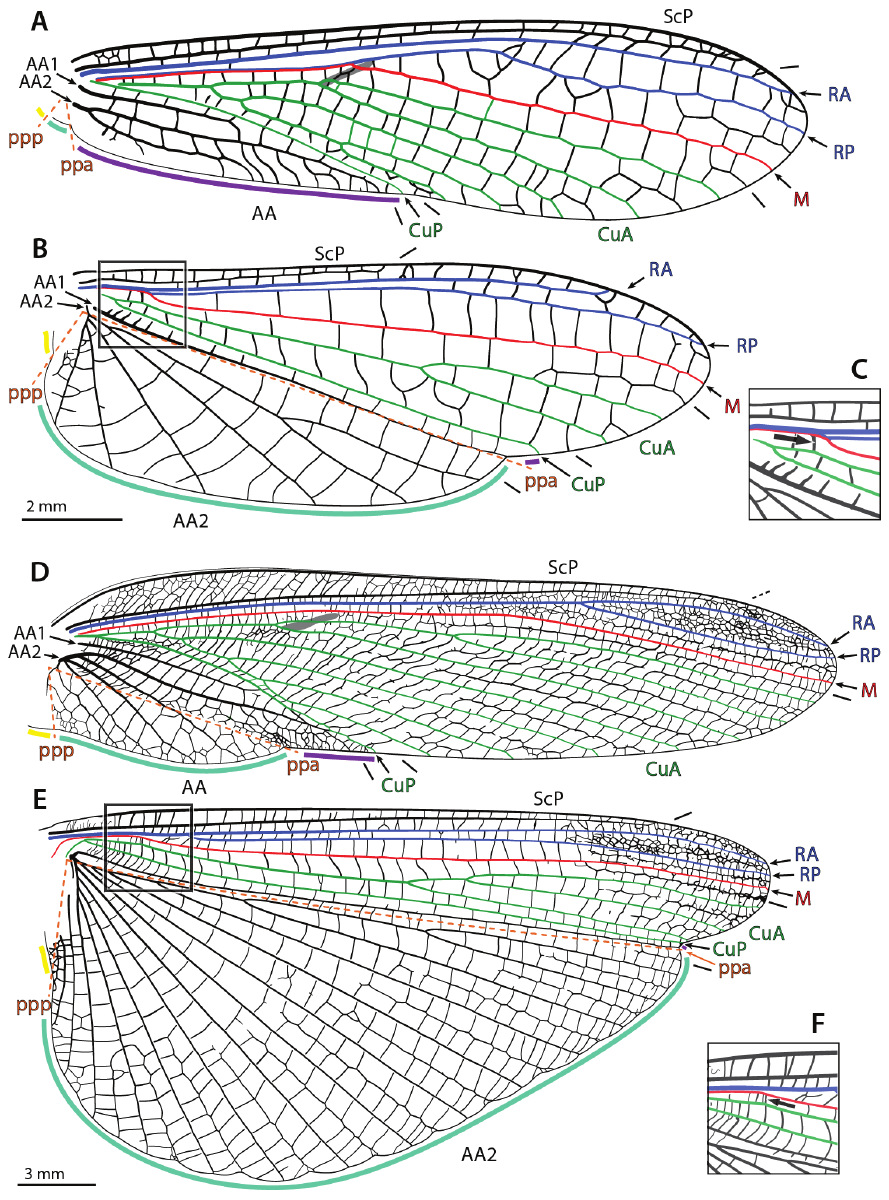
Figure 5. Annotated illustrations of fore- and hindwing venation and structures in Mantoida maya Saus- sure & Zehntner, 1894 ( A – C ) and Mantis religiosa ( D – F ). A, D forewing B, E hindwing C, F detail of the arculus as located on B, E respectively (enlargement 1.5×; black arrow indicates the arculus). Abbre- viations: AA = anterior Analis; AA1 = first anterior Analis; AA2 = second anterior Analis; CuA = anterior Cubitus; CuP = posterior Cubitus; M = Media; ppa = plica prima anterior; ppp = plica prima posterior; RA = anterior radius; RP = posterior radius; ScP = posterior subcostal; color coded areas: gray = stigma ( sti ); purple = preplicatum; turquoise = plicatum; yellow =